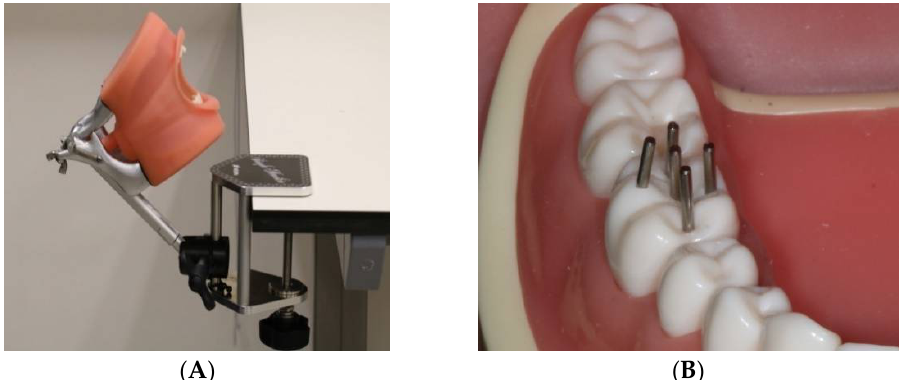
Figure 2. ( A ). Mobile device, desktop fixation, silicone simulating soft tissue. ( B ). Close view: tooth 36 with all 5 pins. 36 with all 5